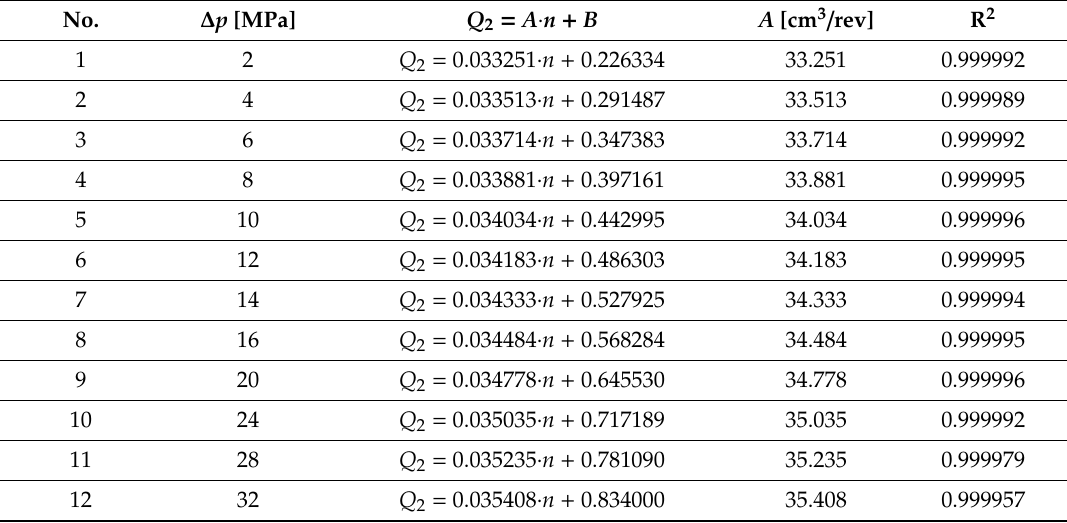
Table A3. Equations Q 2 = A · n + B of motor output flow rate at ∆ p i = const. (new method without the influence of the oil compressibility).